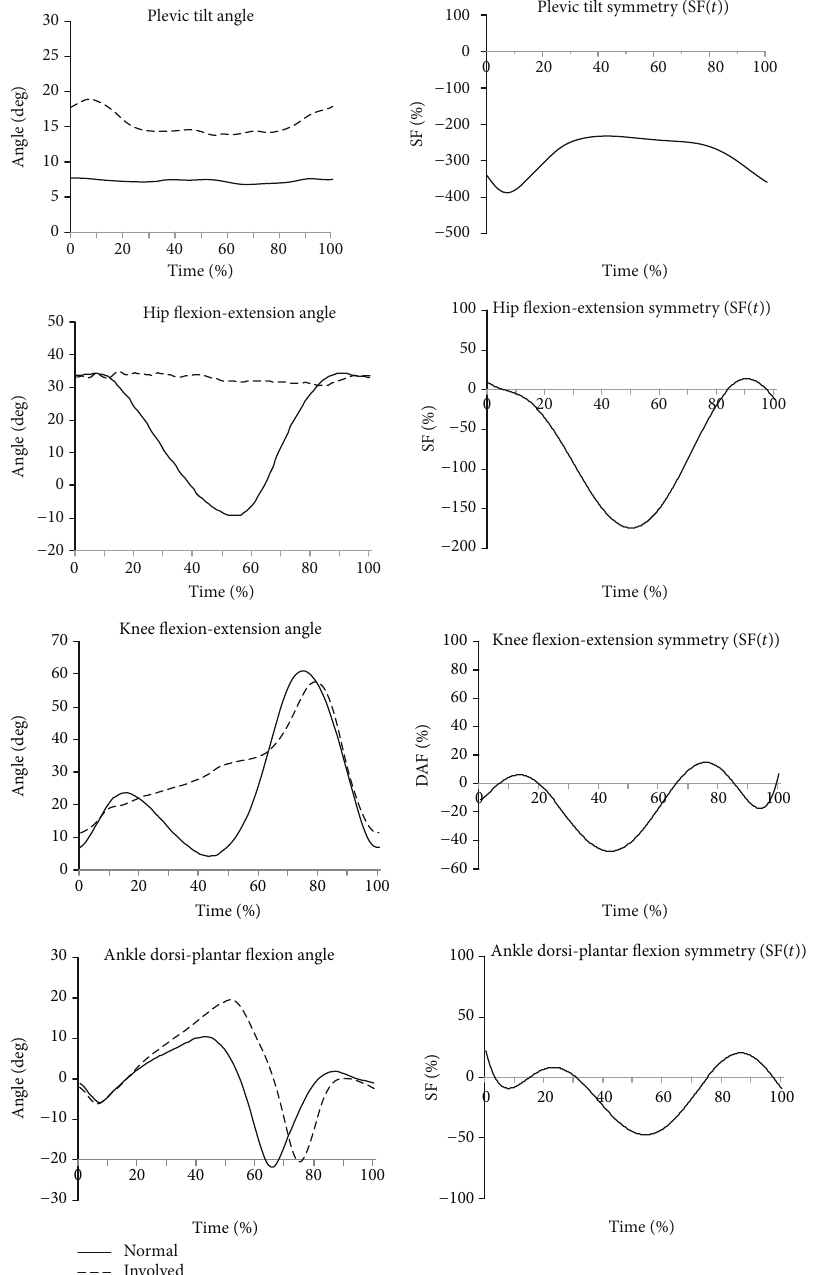
Figure 4: Angular joint kinematics in the sagittal plane and corresponding symmetry function (SF) for the involved limb of the uTHR group vs. normal subjects. Positive values of SF indicate normal curve dominance in asymmetry, while negative values show dominance of the curve for involved limb of the uTHR